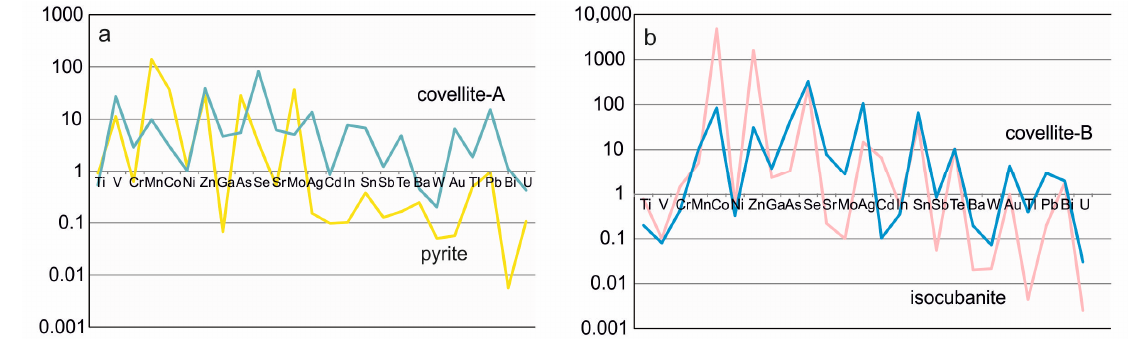
Figure 8. Comparative diagrams for the median trace element (TE) composition of pyrite and covellite-A ( a ) and isocubanite and covellite-B ( b ) (ppm).